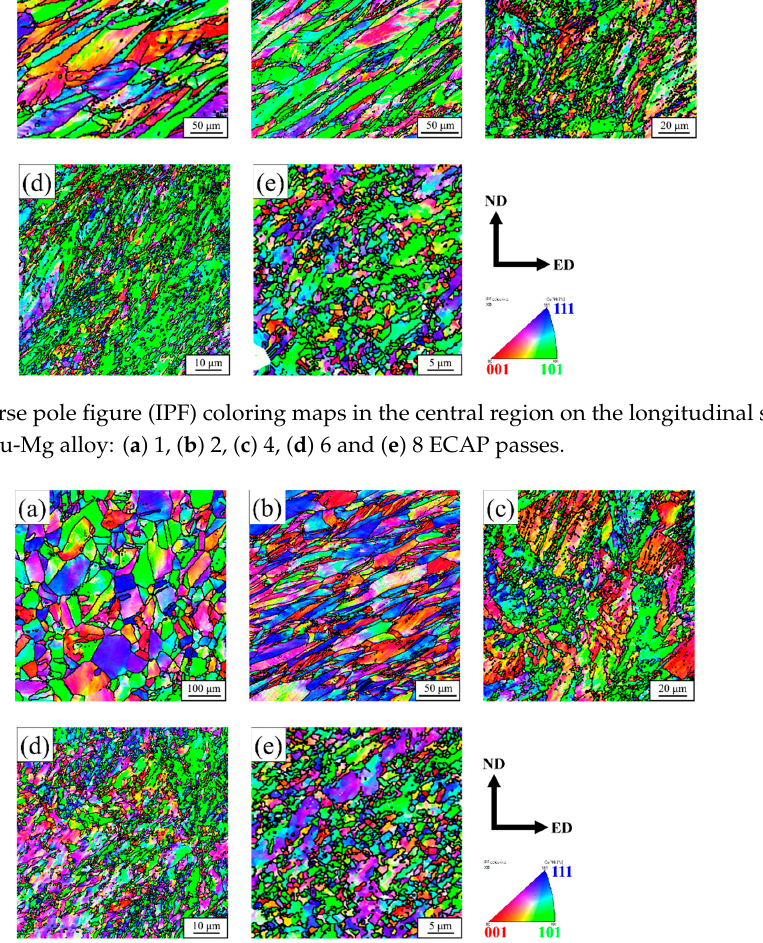
Figure 5. IPF coloring maps in the bottom region on the longitudinal section of the ECAPed Cu-Mg alloy: ( a ) 1, ( b ) 2, ( c ) 4, ( d ) 6 and ( e ) 8 ECAP passes.